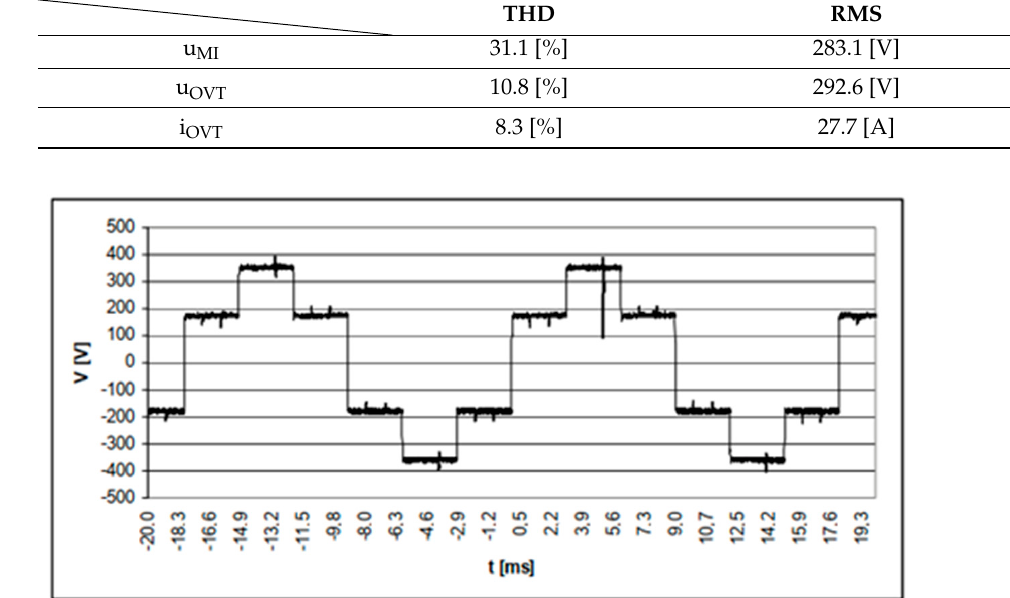
Figure 6. The phase voltage waveform of the MI main inverter gained during experimental tests.